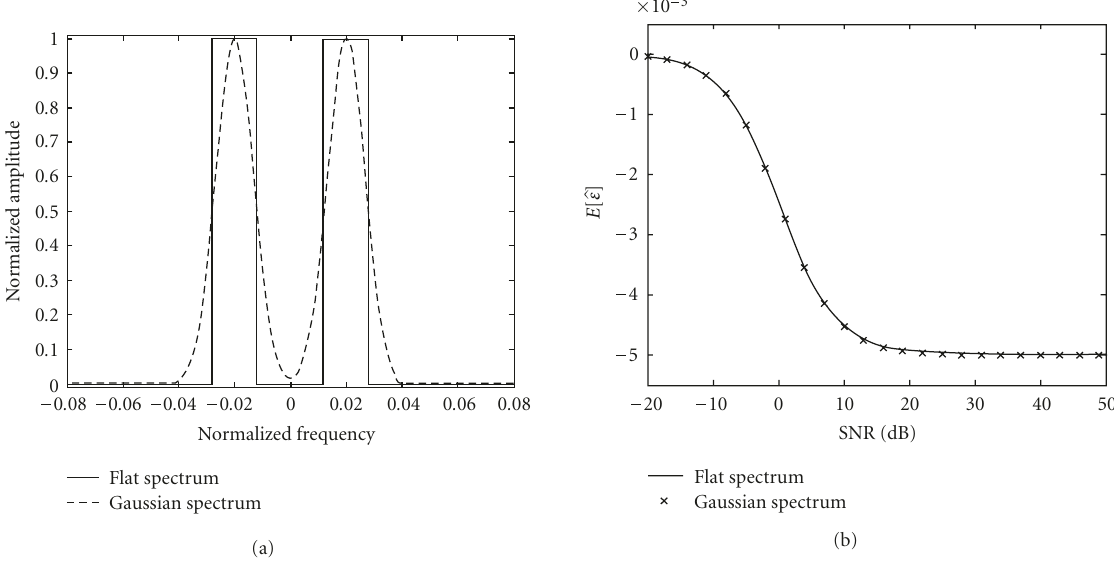
Figure 4: Influence of the spectrum shape on estimation. (a) Fourier transform of signals with a flat spectrum and Gaussian spectrum. (b) Mean time-scaling factor estimated from signals with a flat spectrum and from signal with a Gaussian spectrum. Except the shape, all spectrum characteristics (central frequency, bandwidth) are similar. The shape change does not make di ff erence on the estimated time- scaling factor.